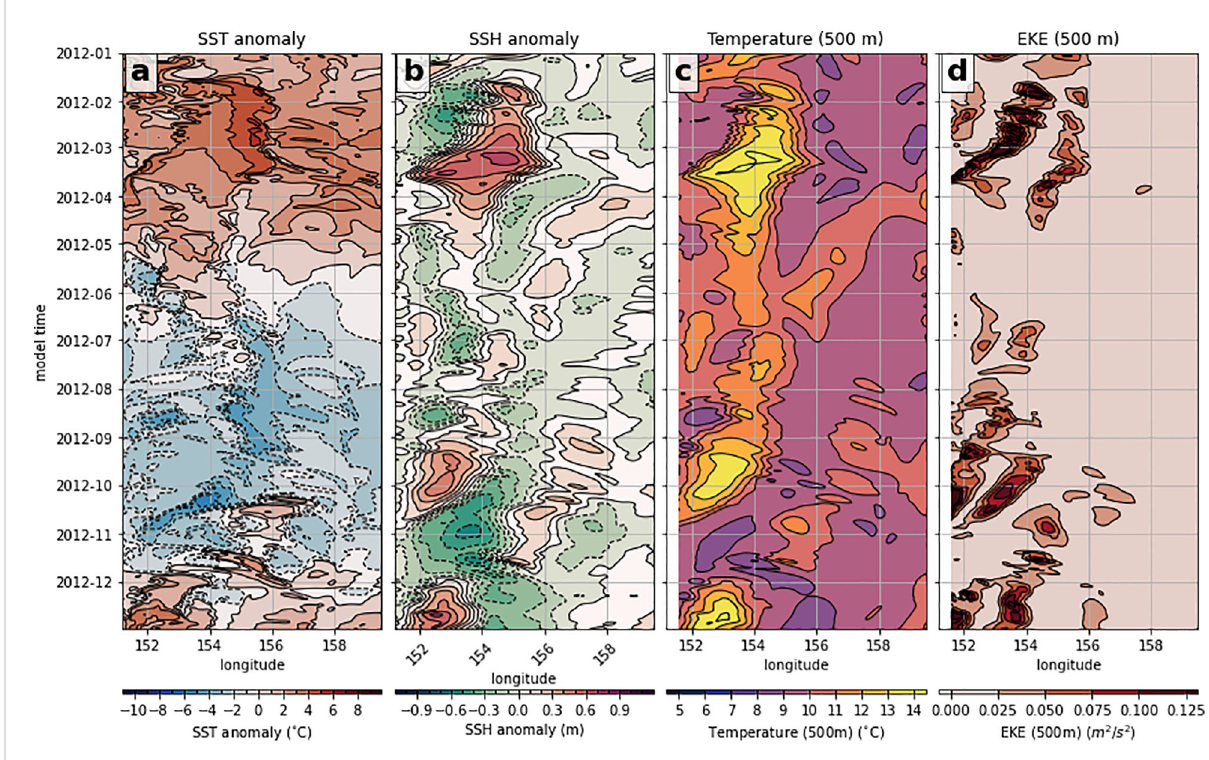
FIGURE 2 Hovmöller diagrams show the longitude – time variability in the ref state along the XBT-S transect (see Figure 1) for two surface quantities (A) SST anomaly, (B) SSH anomaly, and two subsurface quantities (C) temperature at 500 m and (D) EKE at 500 m. All anomalies are calculated by subtracting the mean value at each longitude over the time period Jan-2012 – Jan-2013. Contour intervals are indicated with marks in the